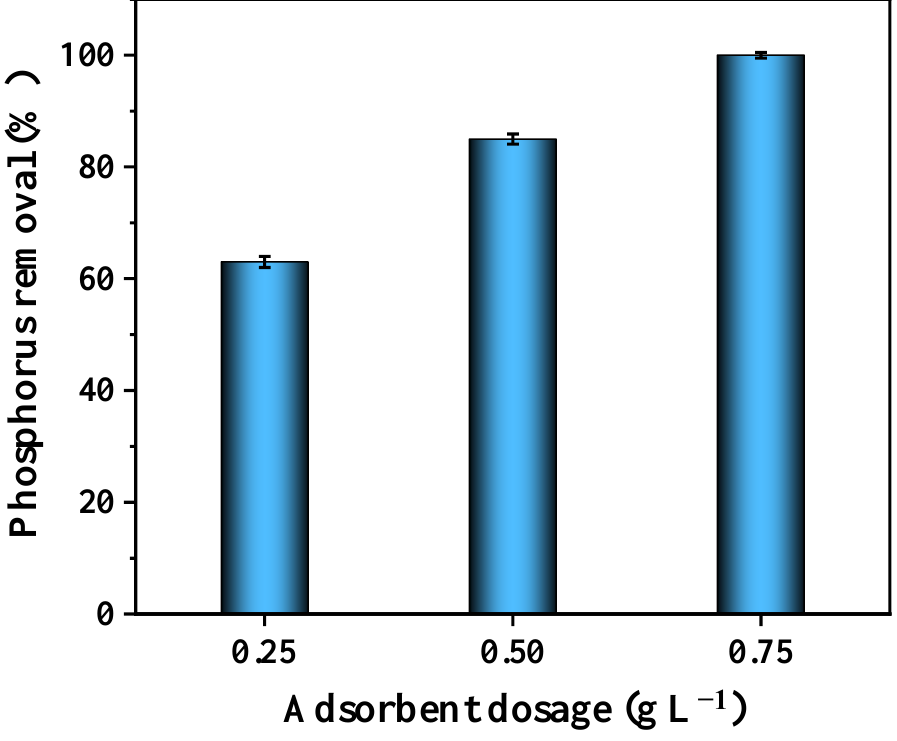
Figure 8. Adsorption of phosphorus from livestock wastewater with 2MgO/BC-450-0.5.